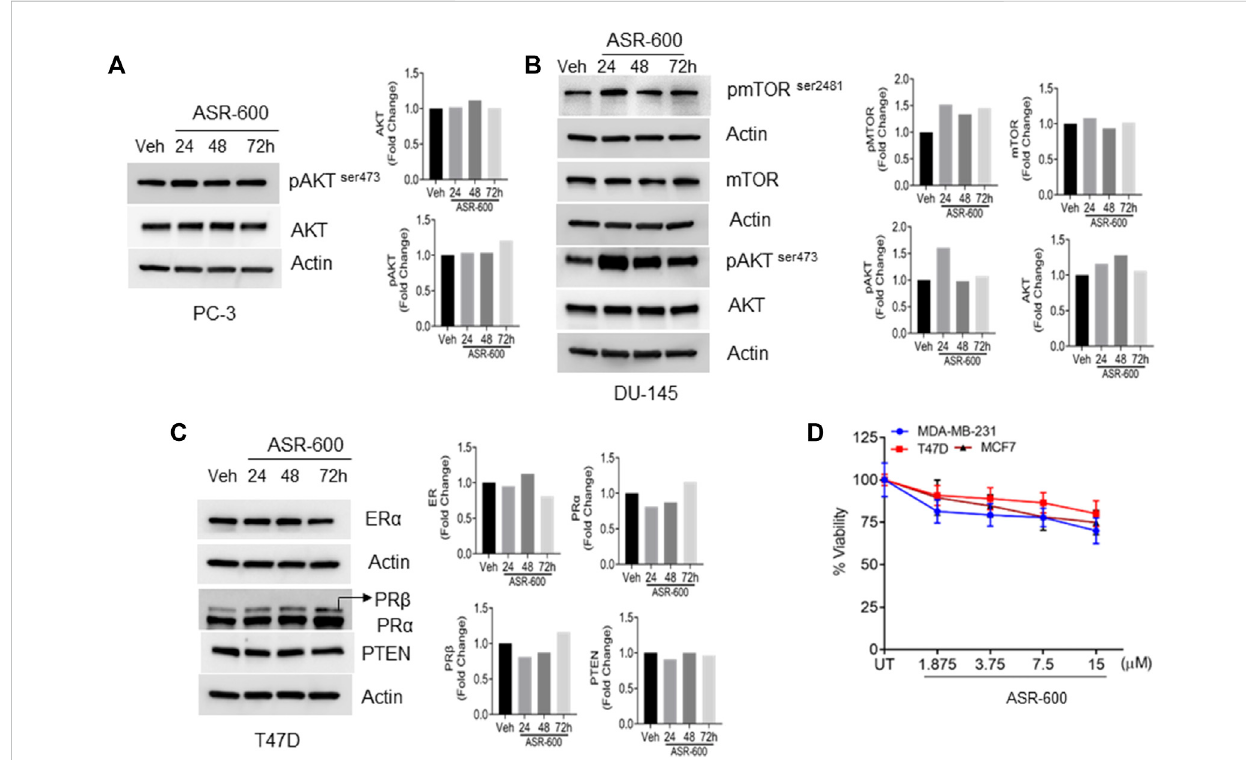
FIGURE 6 ASR-600 speci fi cally targets AR in CaP cells: (A – C) . Immunoblots of indicated antibodies in vehicle or ASR-600 treated PC-3, DU-145, and T47D cell lines. (D) . Cell viability assay results of vehicle or ASR-600 treated ER-positive and ER-negative breast cancer (MCF-7, T47D, and MDA-231) cell lines.